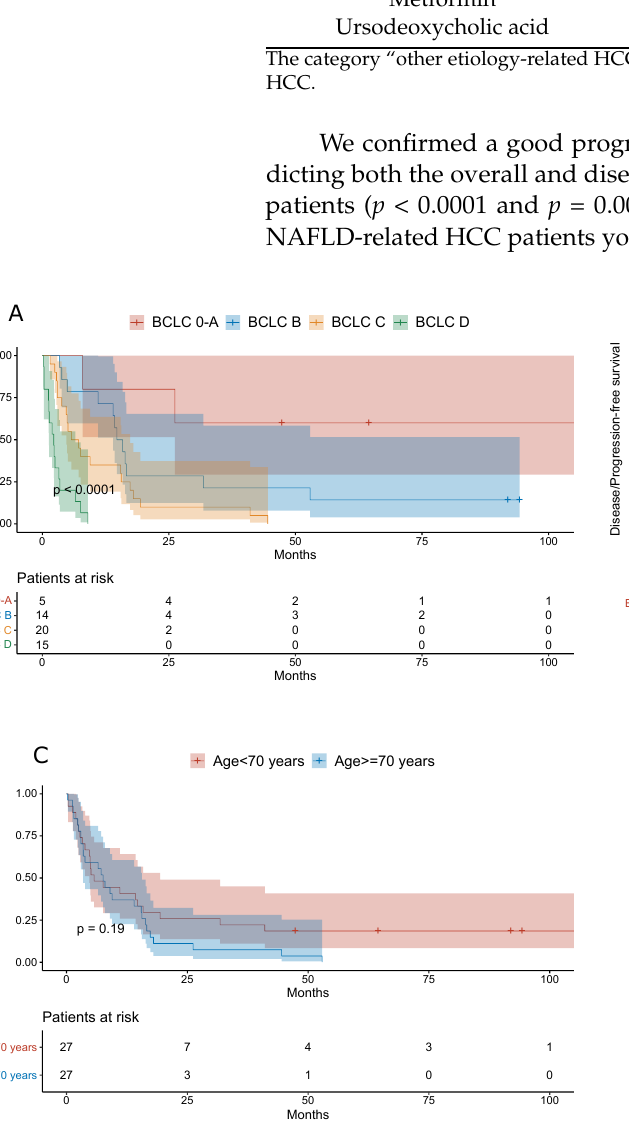
Figure 2. ( A ) Overall survival of NAFLD-related HCC patients. ( B ) Disease-/progression-free survival of NAFLD-related HCC patients. ( C ) Overall survival of NAFLD-related HCC patients stratified by age (cut-off, 70 years).